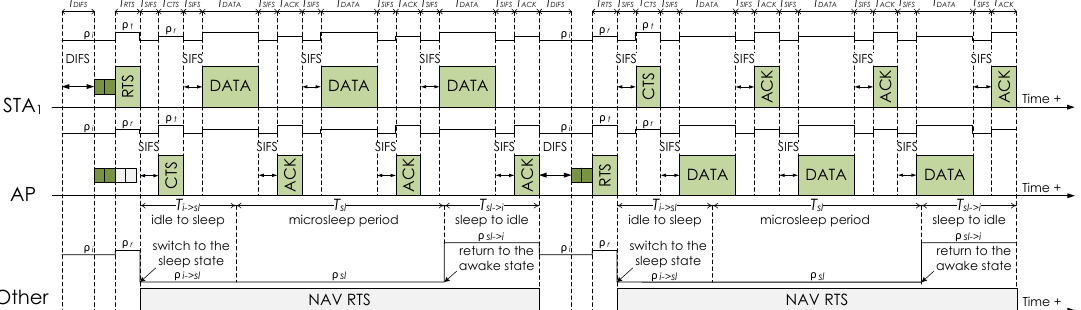
Figure 1. Operation example of the TXOP PSM-based mechanism when the RTS/CTS handshake is enabled. First STA 1 and then the AP send a burst of data frames to each other, while other STAs sleep based on the duration carried in the RTS frame. The energy profiles of STA 1 , the AP, and other STAs during transmission, reception (or overhearing), idle, and sleep periods are shown in the figure. The notations of time and power consumption included in the figure are used in the analytical model presented in Section